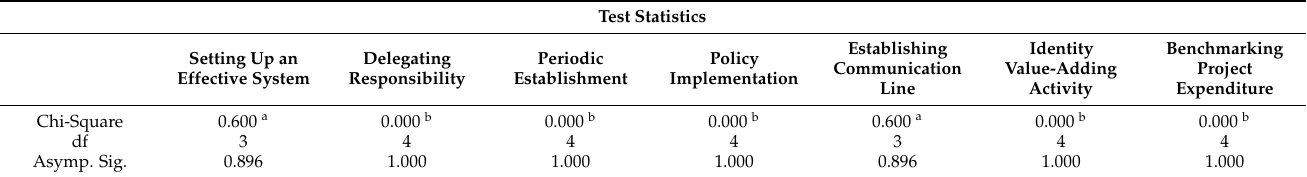
Table 11. Chi-square statistical analysis on communication, authority, and responsibility parameters of the proposed model.